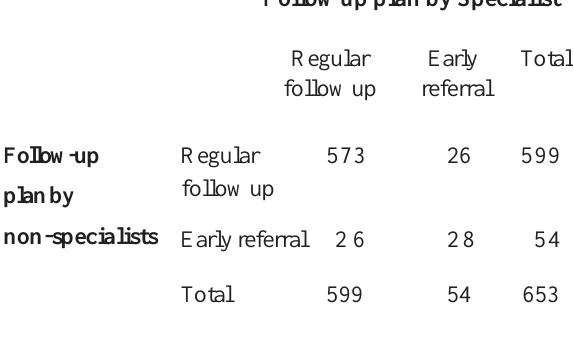
Table 4. Agreement on the follow up plan by ophthalmologist and non-specialists Follow up plan by